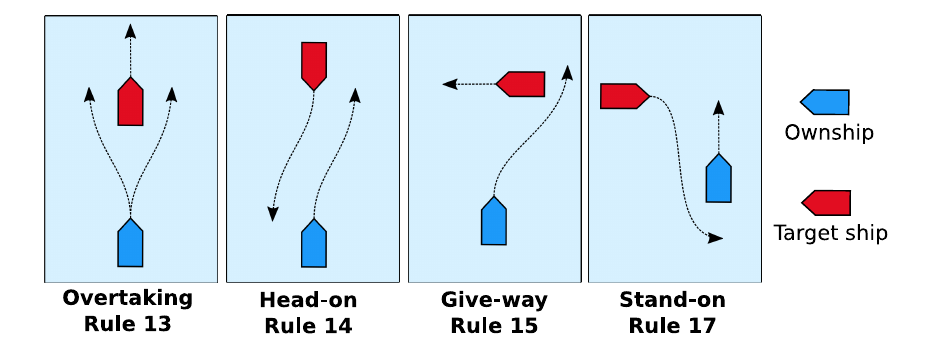
Figure 3: Illustration of COLREGs rules 13-15 and Rule 17, as seen from the OS in